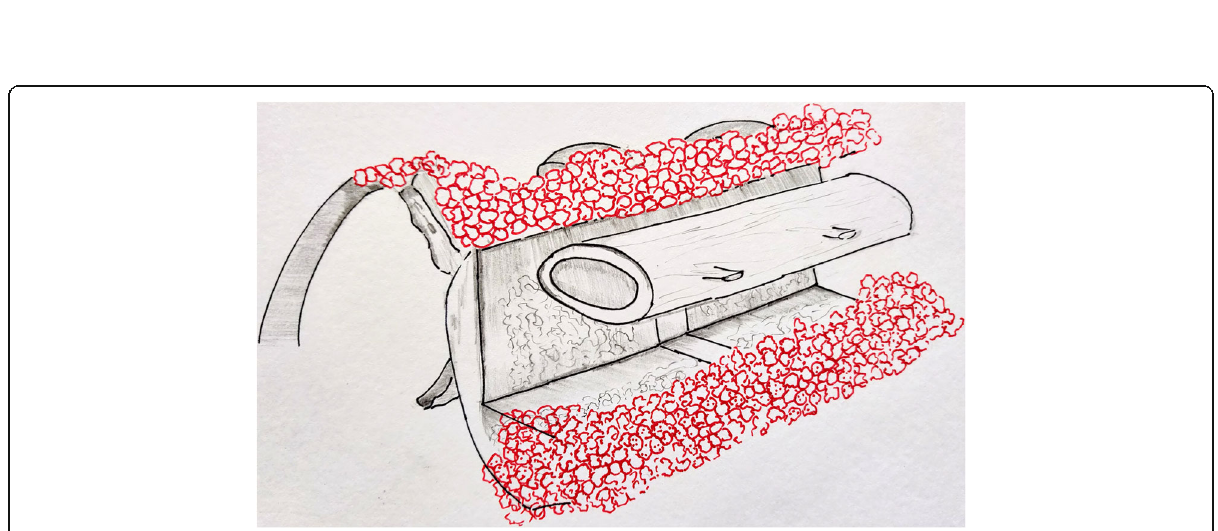
Fig. 6 The decompressed cord. After completion of osteotomy procedure, intraoperative O-arm acquired CT images confirming complete gibbectomy (inset)